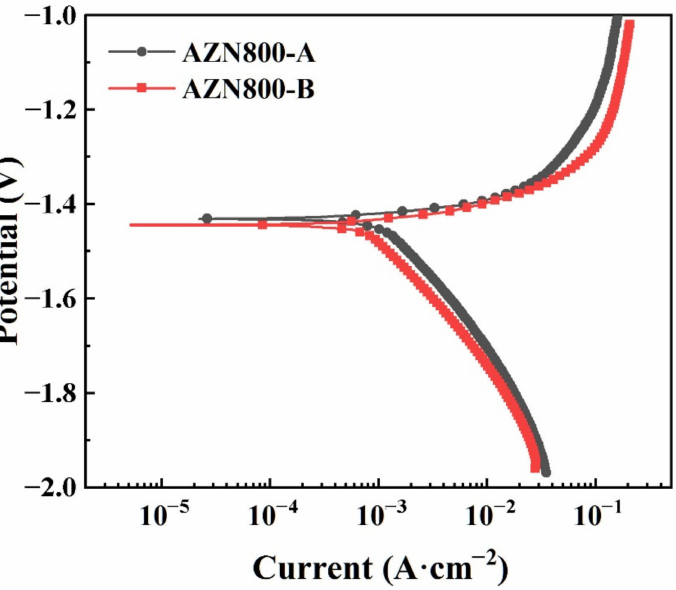
Figure 7. Polarization curves of the AZN800-A and AZN800-B alloys in 3 wt.% KCl at 25 ◦ C. Table 2. Tafel fitting results obtained from polarization curves of the AZN800-A and AZN800-B alloys in 3 wt.% KCl at 25 ◦